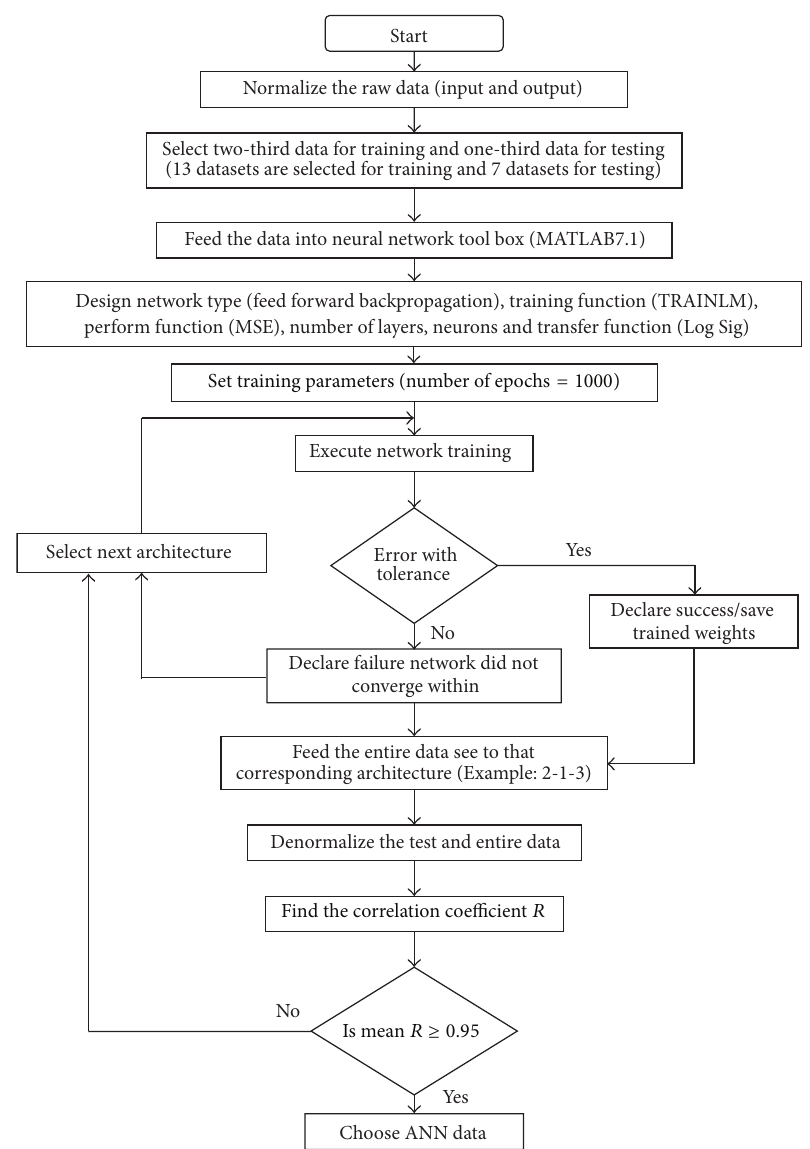
Figure 5: Flow Diagram for training and testing of ANN